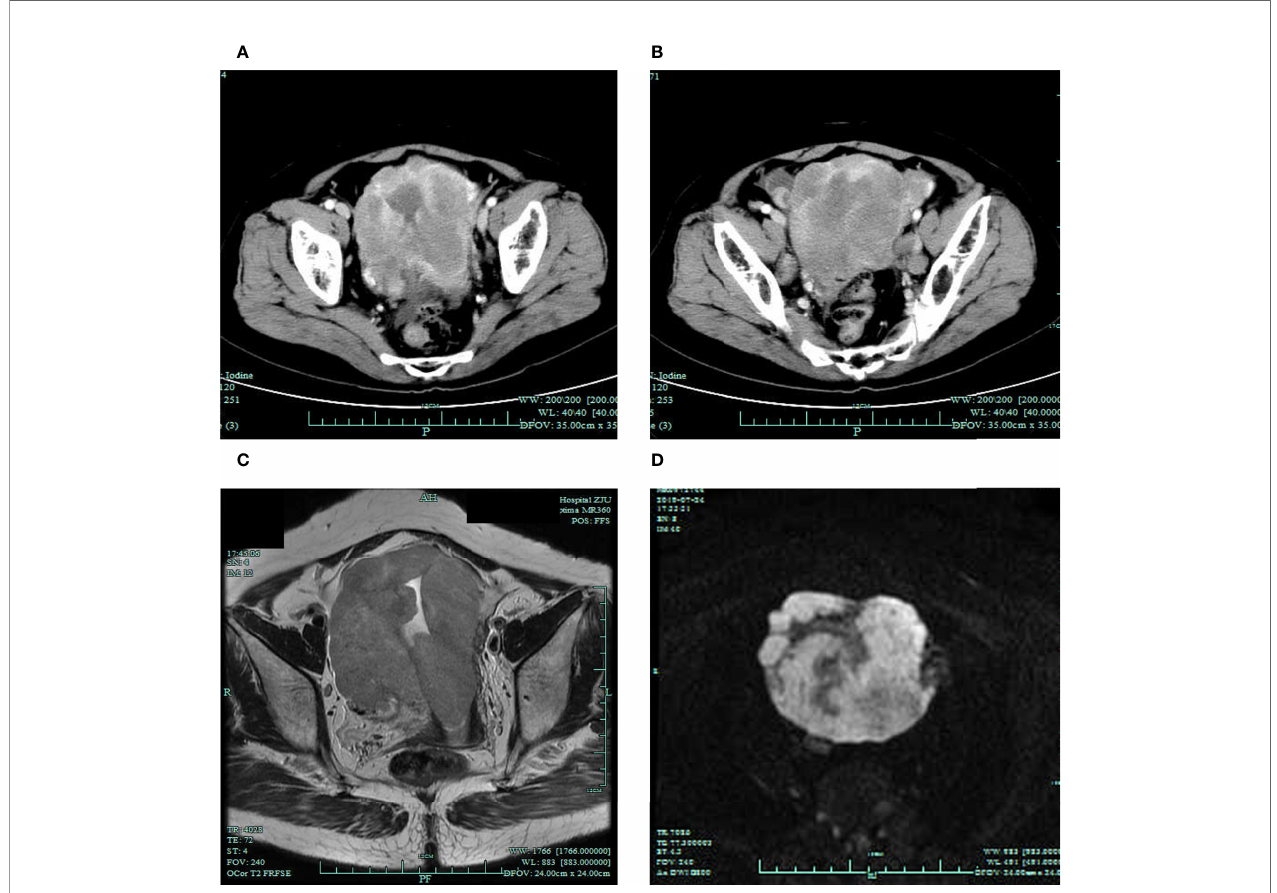
FIGURE 1 | Radiographic fi ndings before the treatment. (A, B) Preoperative CT scan showing the masses in the uterus and bilateral ovaries. MRI T2WI (C) and DWI (D) showing the mass in the